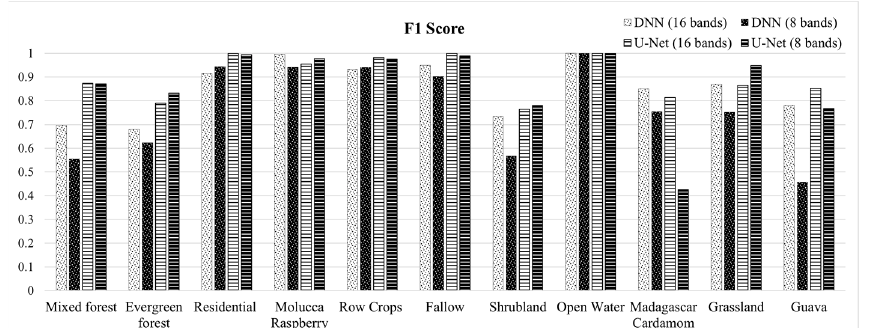
Figure 7. F1 scores (Equation (6)) for the U-Net and DNN models including (16 bands) and exclud- ing (8 bands) SWIR bands across all classes. The U-Net and DNN models trained on 16 bands show a higher F1 score compared to the models trained on eight bands.